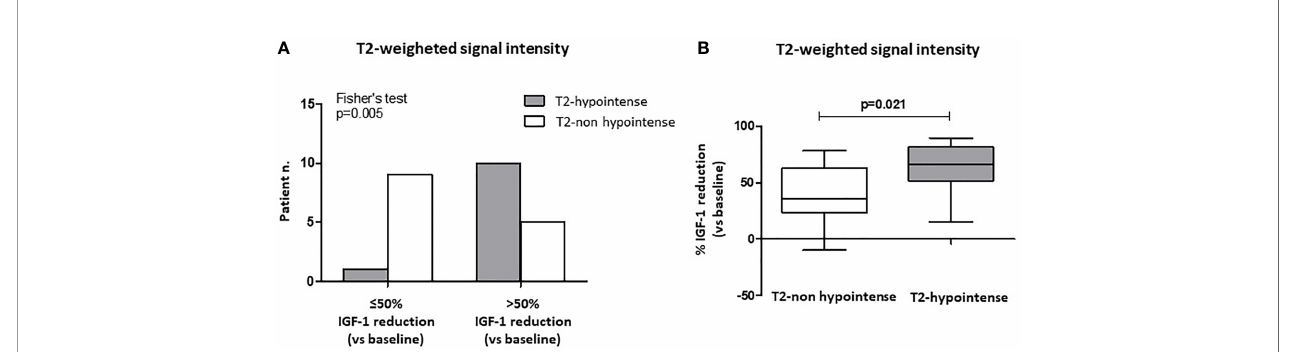
FIGURE 3 | Biochemical response after fi rst-line SRL treatment (6 months) with respect to T2-weighted signal intensity at MRI of the sella turcica. A higher percentage of patients with T2-weighted hypointense tumors at MRI achieved a >50% IGF-1 reduction after 6-month SRL treatment, compared to those harboring a non-hypointense lesion (A) . Patients with a T2-hypointense tumor had a higher % IGF-1 reduction compared to the subjects with a non-hypointense lesion (B) . SRL, somatostatin receptor